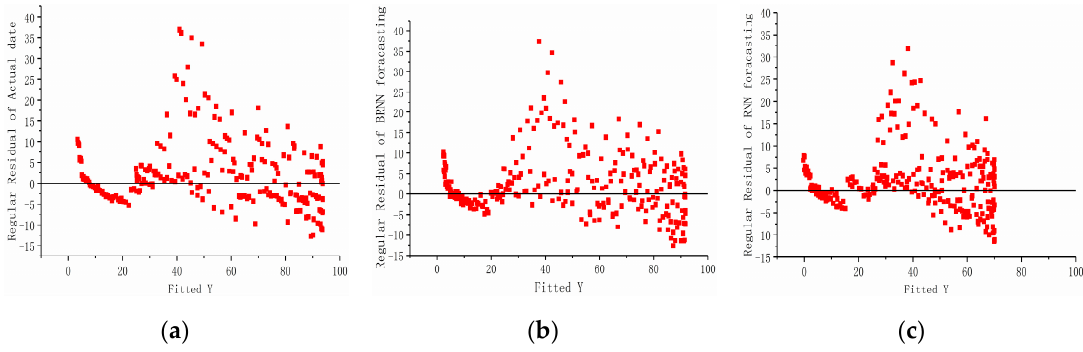
Figure 12. This is the residual diagram of the predicted results for each model. The graph ( a ) is the regular residual of actual data under the fitted Y value. That of ( b ) is the regular residual of BRNN model under the fitted Y value. The one of ( c ) is the regular residual of RNN model under the fitted Y value.